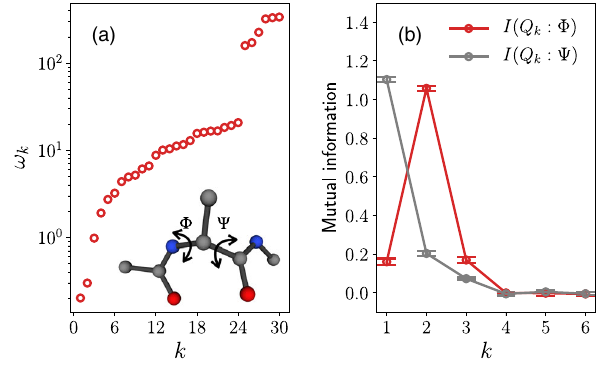
FIG. 3. (a) The learned frequencies of harmonic chain present in Sec. IV B in the prior distribution [Eq. (4)] and the analytical normal-mode frequency. (b) The Jacobian ∇ q slowest collective coordinates with respect to the original coordinates. Solid lines are the analytical solution.